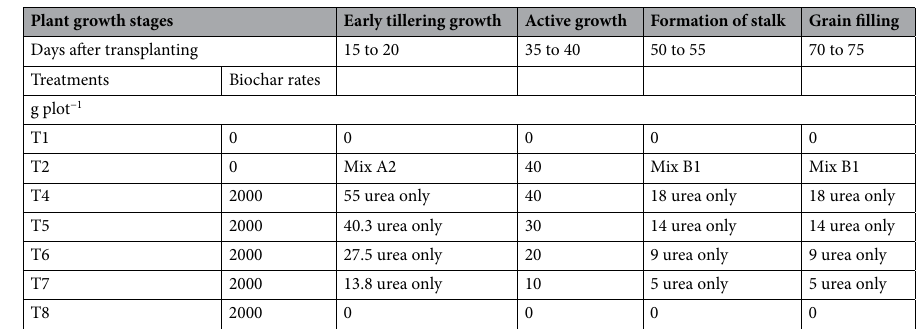
Table 2. Chicken litter biochar rate and fertilization schedule for the field study. Mix A2 = (55 g Urea + 50 g TSP + 24 g MOP). Mix B2 = (18.3 g Urea + 18.7 g TSP + 19.8 g MOP + 1.4 MgO). TSP—Triple superphosphate; MOP—Muriate of potash; MgO—Magnesium oxide.